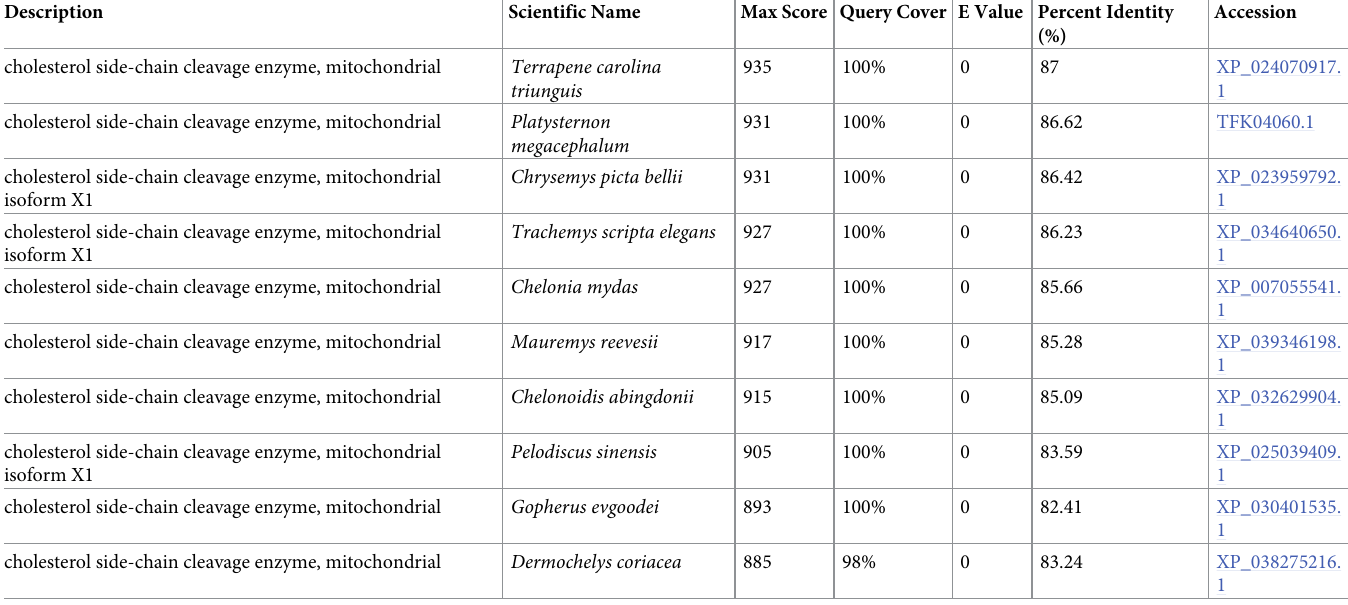
Table 2. BLAST output of the g19.t1 sequence. Top hits predicted a mitochondrial cholesterol side-chain cleavage enzyme with a high query coverage, high percent identity, and low E value.